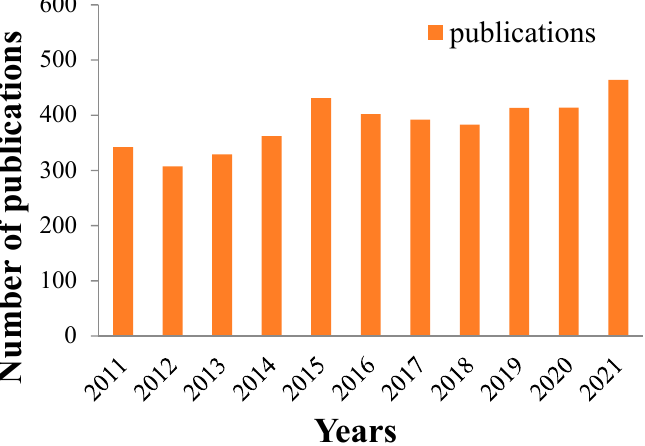
Figure 5. Number of publications of fluoropolymers applied in membrane distillation and membrane crystallization in the past 10 years in Web of Science (searched by using the key words “fluoropolymer membrane”, “membrane distillation” and “membrane crystallization”).